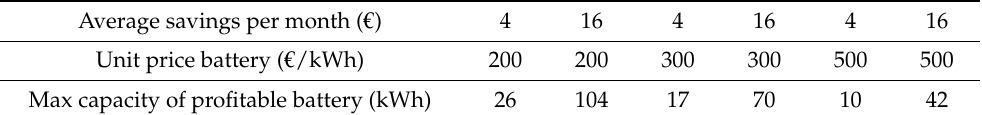
Table 1. Investment cases for interest of 2% p.a. and 10 years payback time, as dependent on the battery’s unit price.